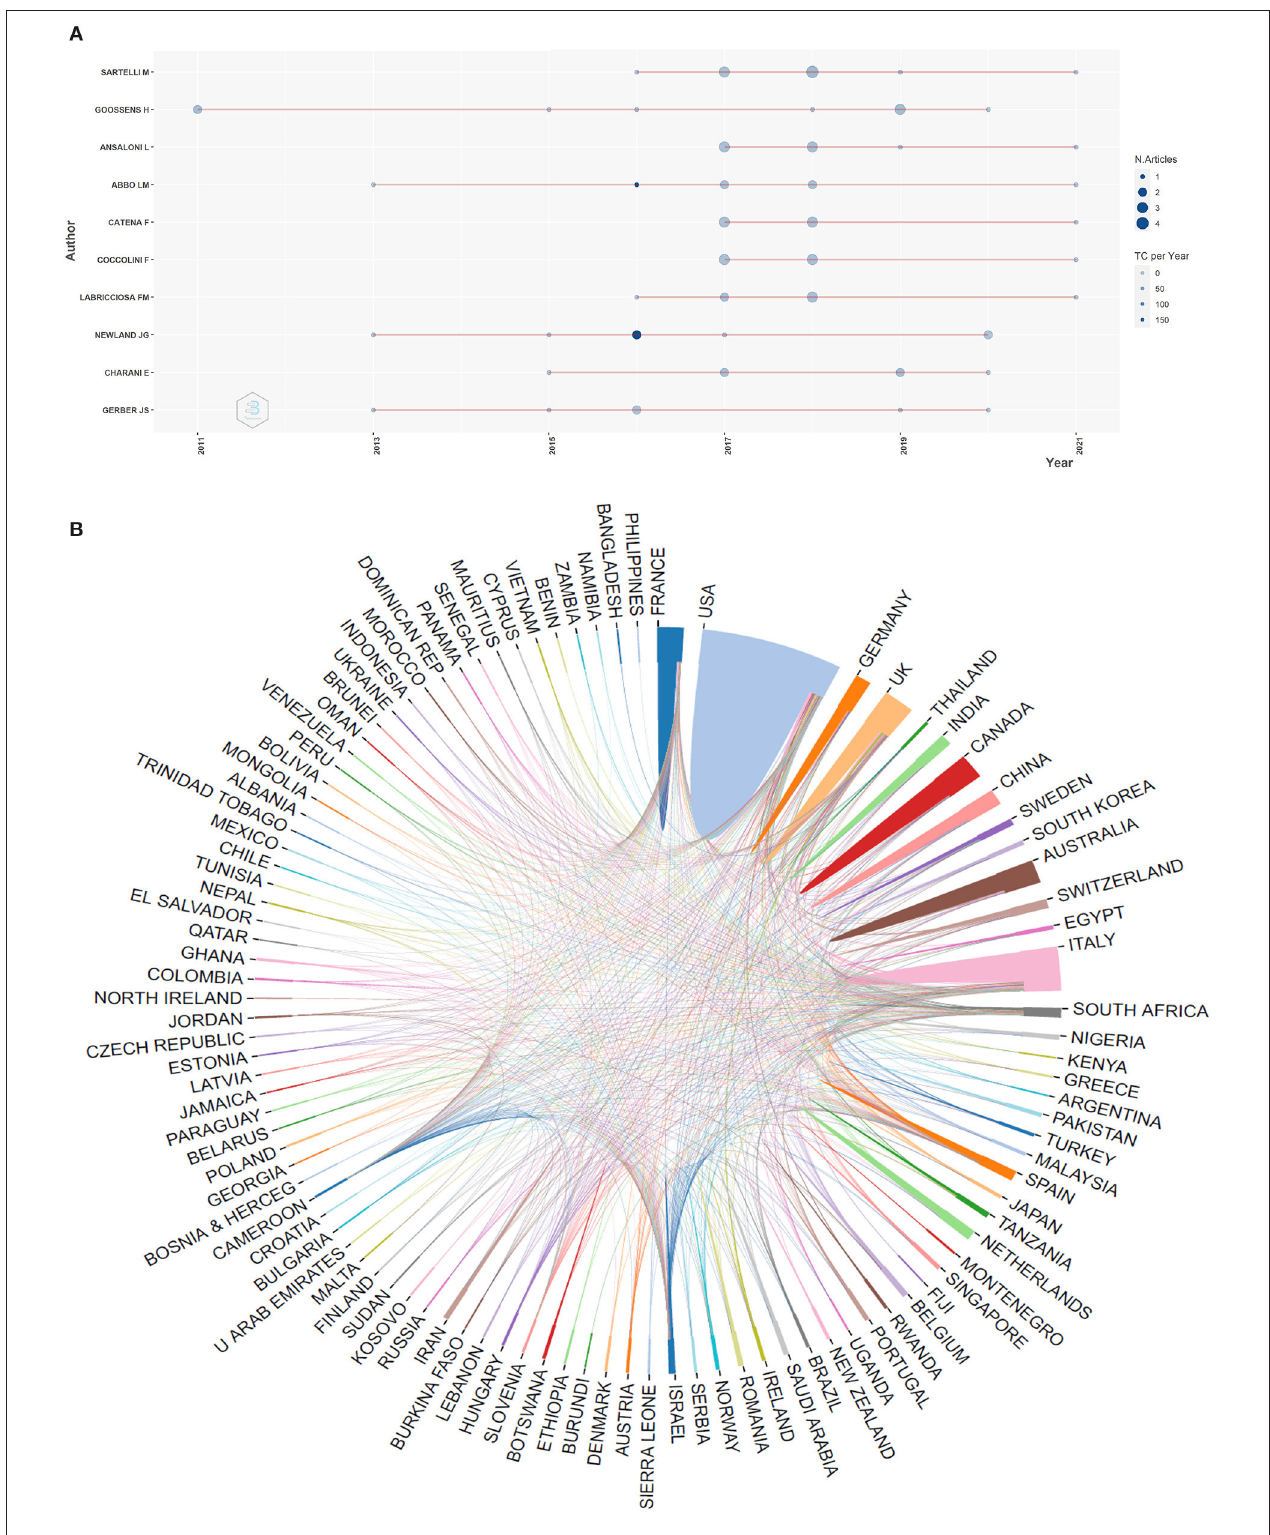
FIGURE 2 | Bibliometric analysis of authors and countries/regions. (A) Top 10 authors’ productions over time. N. articles, Numbers of articles; TC per year, total citation per year. Among authors, Sartelli M was shortened of Massimo Sartelli, he was the author with the highest number of publications; Goossens H was shortened of Herman Goossens, he was most active author over time; Newland JG was shortened of Jason G. Newland, he was the most cited author. (B) Network of countries/regions cooperation. USA was the largest producer.